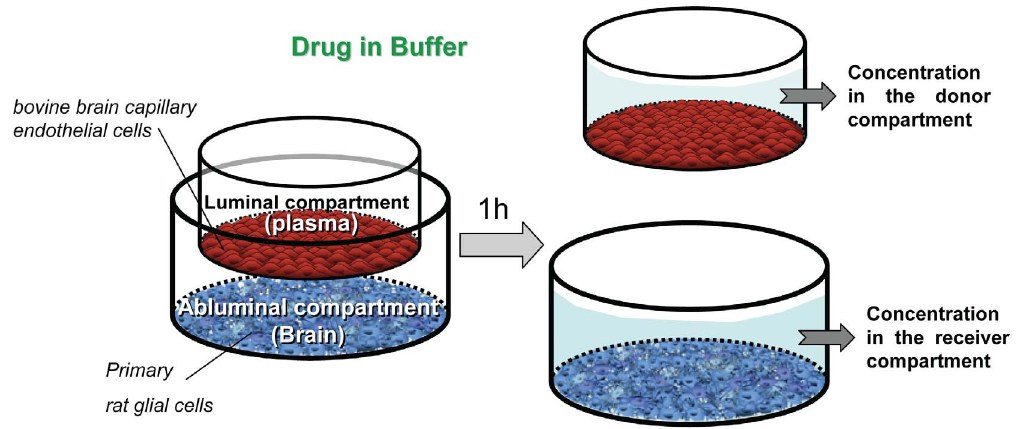
Figure 1. Schematic diagram of the experimental protocol. After 12 days of coculture in cell culture medium, both compartments of the in vitro BBB model consisting of a coculture of brain capillary endothlial cells and rat primary glial cells were filled with Hepes-buffered Ringer’s solution and the compounds dissolved at 2 m M were added in the luminal compartment (i.e donor). The presence of glial cells in the abluminal compartment was used to reproduce the non specific binding to brain tisssue within the brain prenchyma in vivo . After 1 hour, aliquots were taken from both compartments. In vitro Cu,br/Cu,pl at 1 h were calculated by dividing the concentration in the abluminal compartment ( , Cu,br) by the concentration in the luminal compartment ( , Cu,pl) at 1 h. The experimental data at 1 h were computed using the blue-norna steady-state calculator to generate the in vitro steady-state Cu,br/Cu,pl.